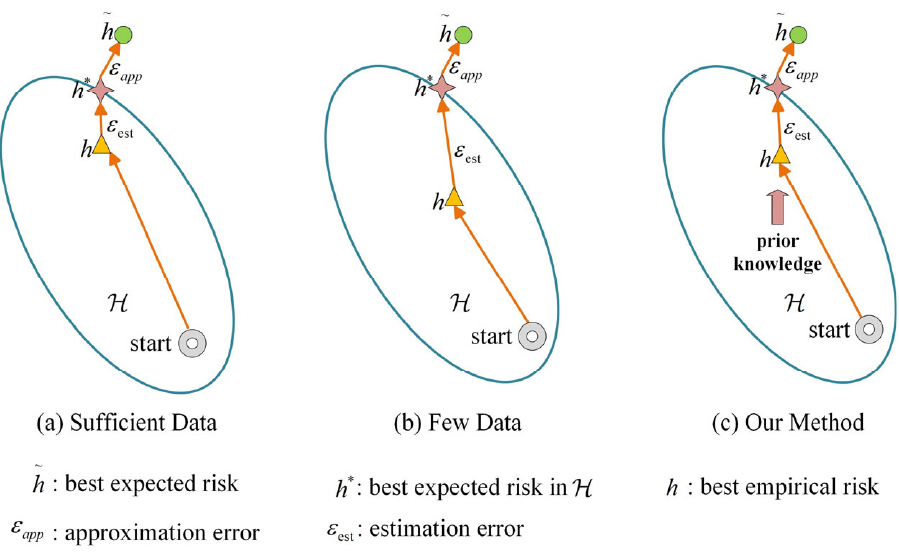
Figure 4. Comparison of learning with sufficient samples, few samples, and our method ( a – c ).